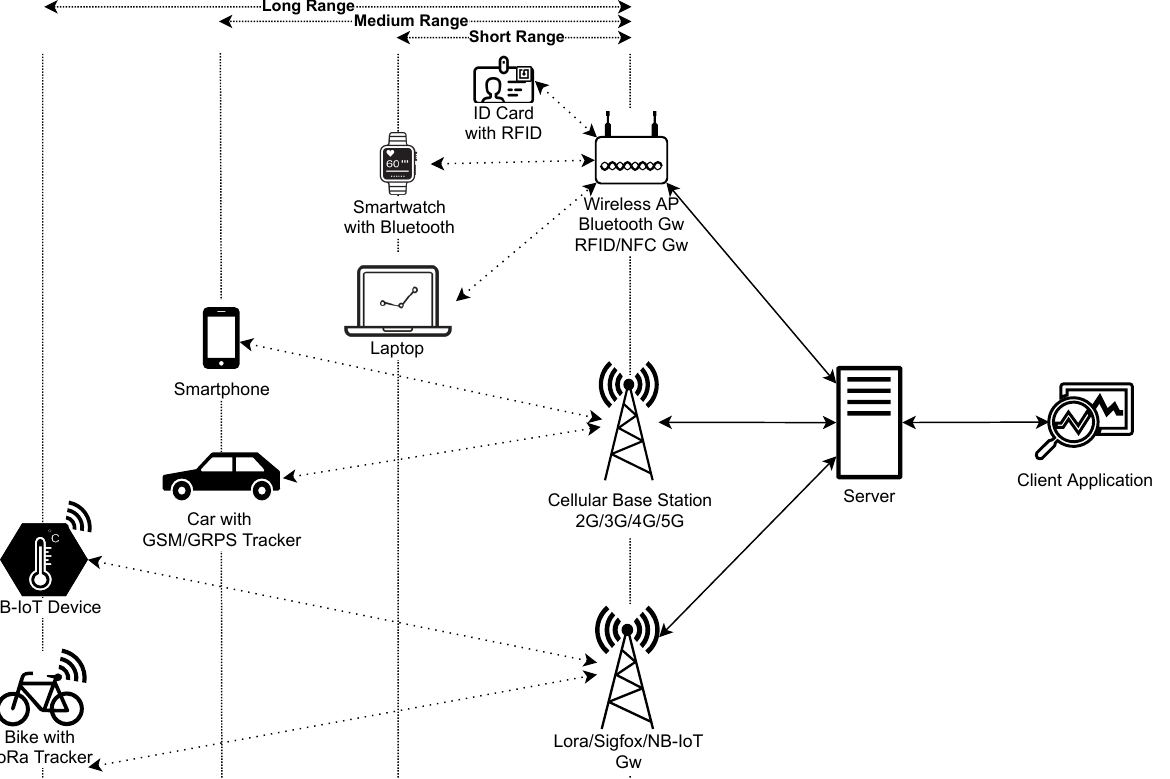
Figure 1. Communication Technologies in IoT applications by